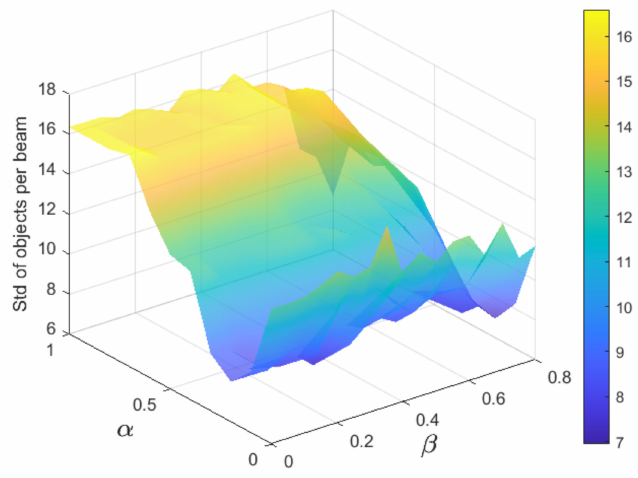
Figure 12. Standard deviation of objects per beam in terms of α and β